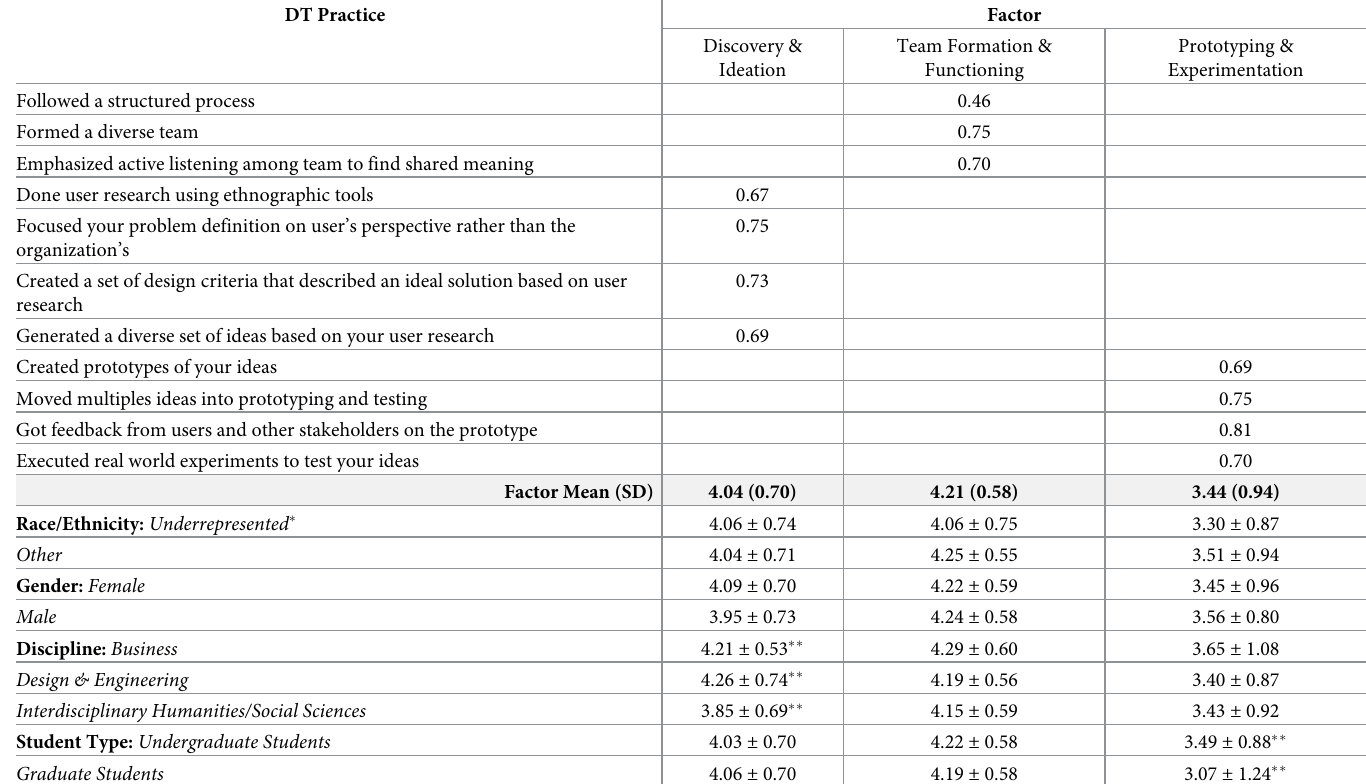
Table 3. Factor loadings and group differences for DT practices experienced in higher education courses (n =